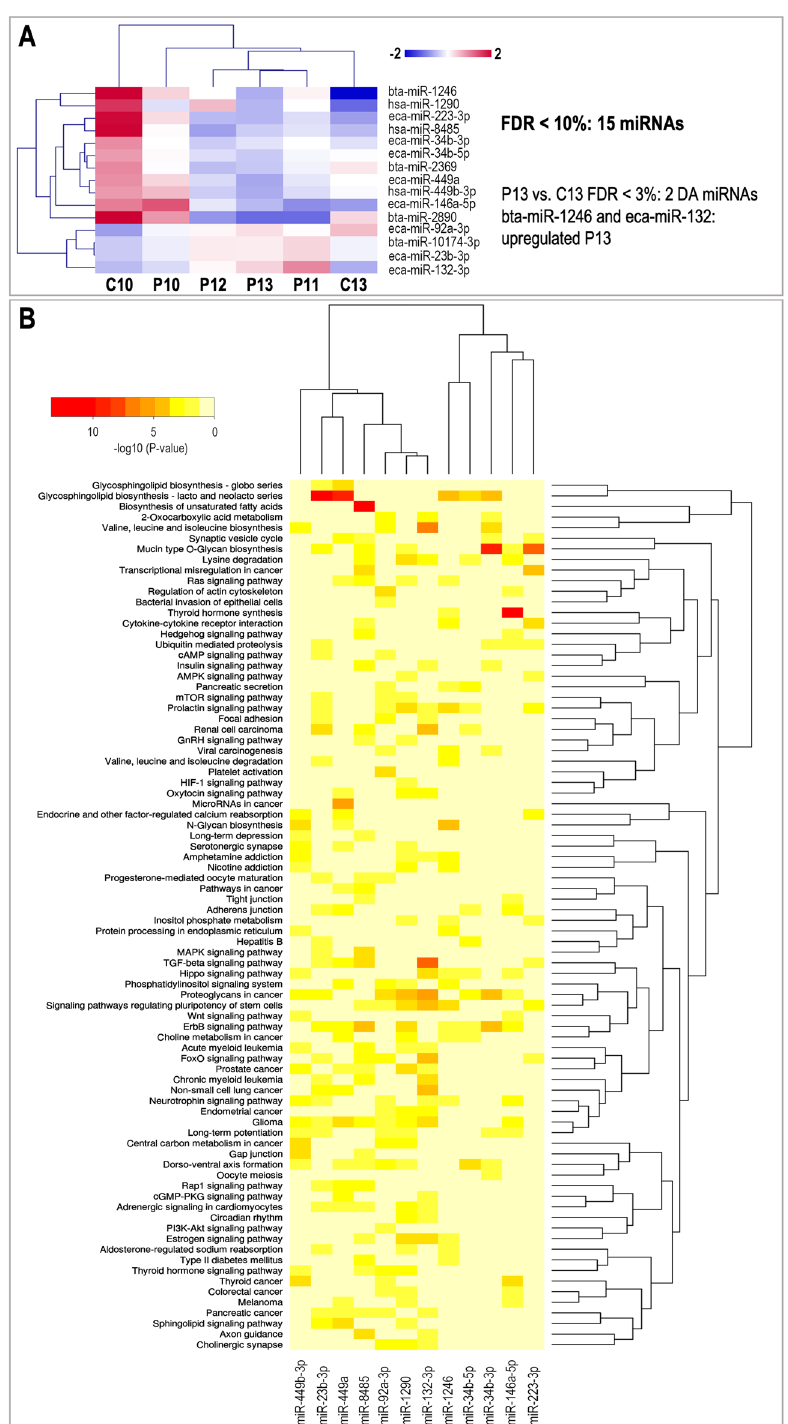
Figure 6. Differential analysis of miRNAs in uEVs across samples and identification of enriched pathways for target genes of differentially abundant miRNAs. ( A ) Mean-centered log2 counts per million (cpm) values were calculated (log2 of CPM of respective sample – mean of all samples) for miRNAs differentially abundant (DA) across experimental groups (FDR 10%). Hierarchical cluster analysis (HCL) (Pearson correlation, MeV software) was performed for DA miRNAs (pregnancy days 10, 11, 12, and 13: P10, P11, P12, and P13; cyclic controls days 10 and 13 post-ovulation: C10, C13). ( B ) Differentially abundant miRNAs were used for cluster analysis based on the presence of interactions of target genes and pathways using DIANA-miRPath v3.0. Heatmap illustrates 12 miRNAs versus their associated pathways based on significance levels. Color scale from red (highest significance) to yellow (not significant). Image created with DIANA-miRPath v3.0 (https:// diana lab.e- ce. uth. gr/ html/ mirpa thv3) 33 and modified with Adobe Photoshop